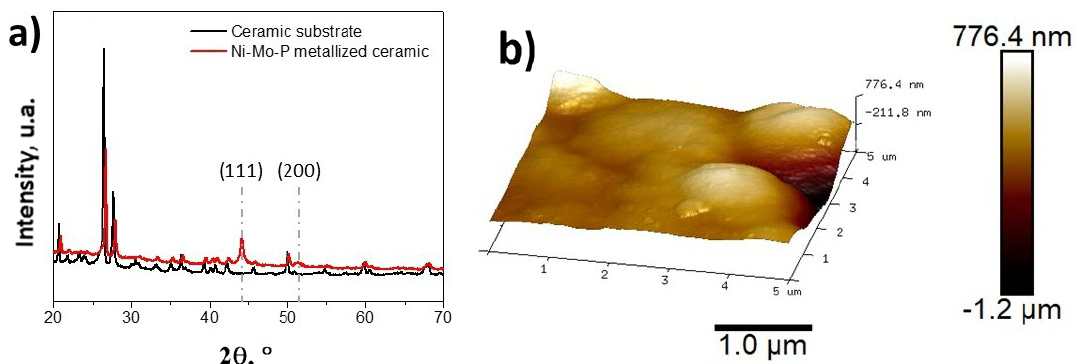
Figure 1. X-ray diffraction pattern ( a ) and Atomic Force Microscopy (AFM) images ( b ) of the NiMoP coating.